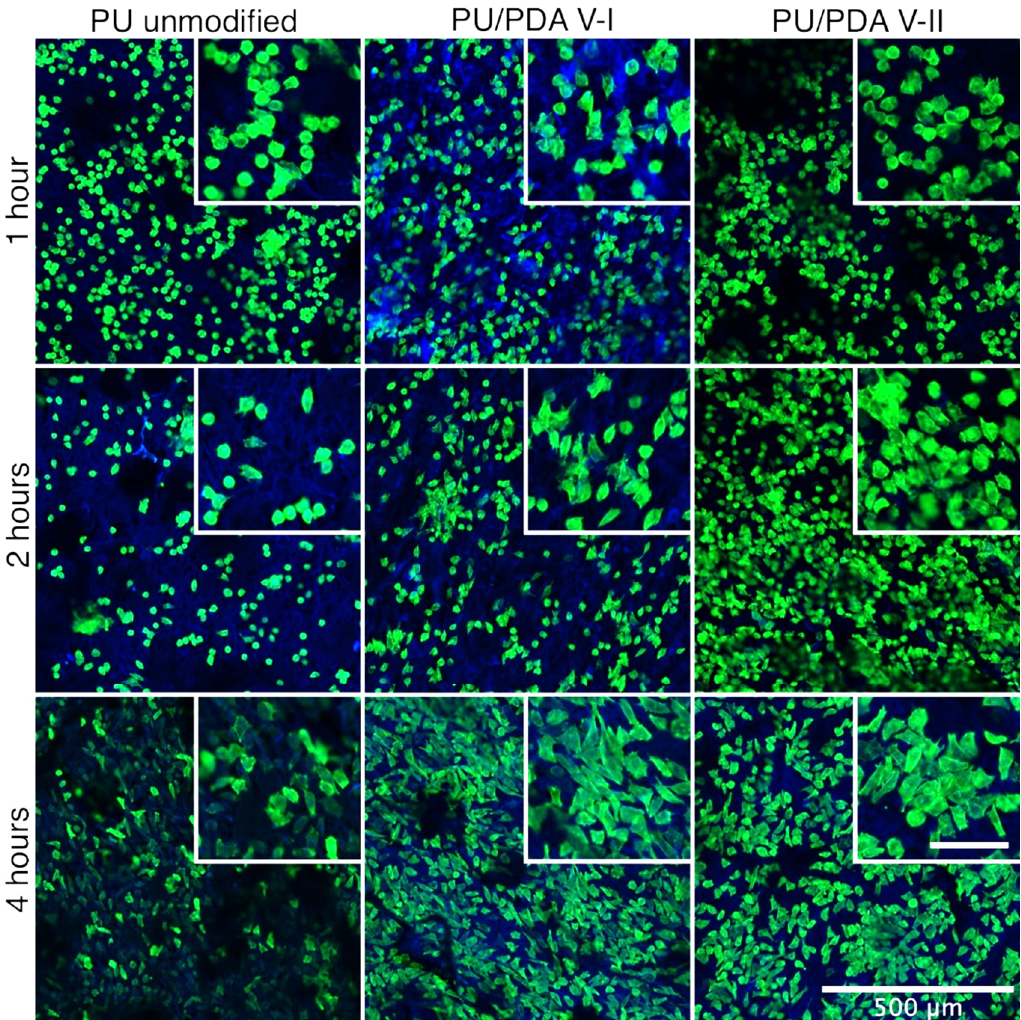
Figure 11. Confocal laser scanning microscope close-up images of L929 cells attachment on the surface of PU unmodified PU and PDA-modified (VI—8 h of the modification, VII—0.5 h of modification) nanofibrous materials, after 1, 2, and 4 h of cells incubation. Insert images enlarge the cells spreading and adaptation to the surface of the modified material. The scale bar in insert image represents 100 µ m.